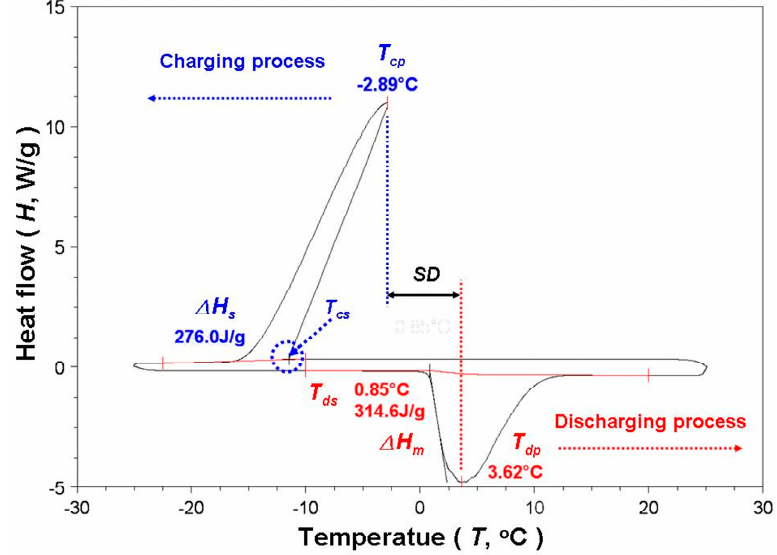
Figure 6. Charging and discharging curve of differential scanning calorimeter (DSC) for water.